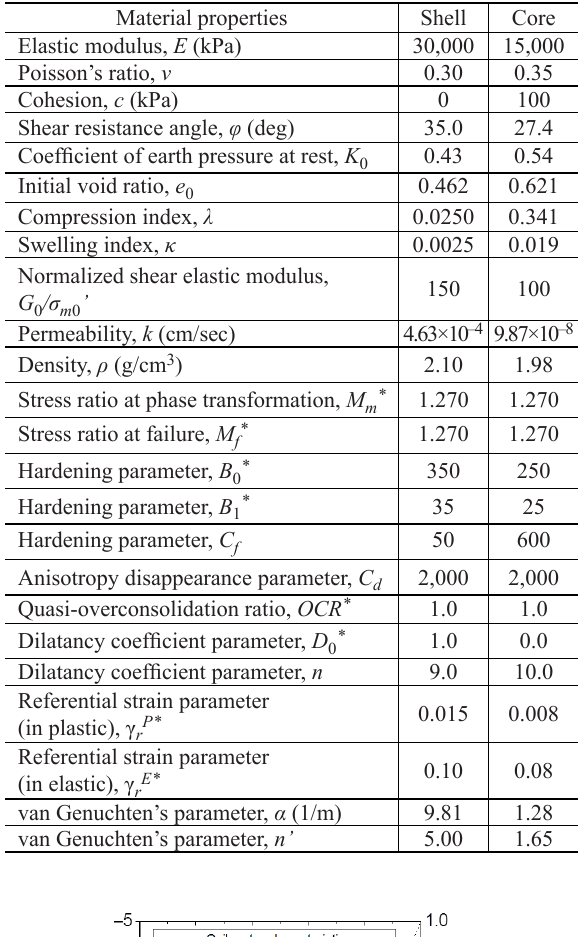
Table 2. Material properties used in the elasto-plastic analysis on the levee Material properties